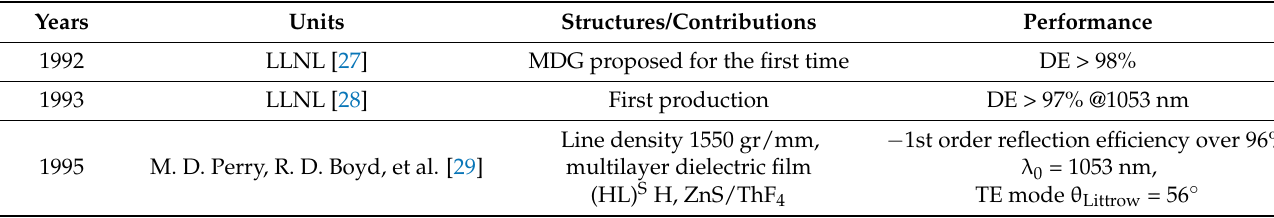
Table 2. Overview of multilayer-dielectric-reflection gratings in recent